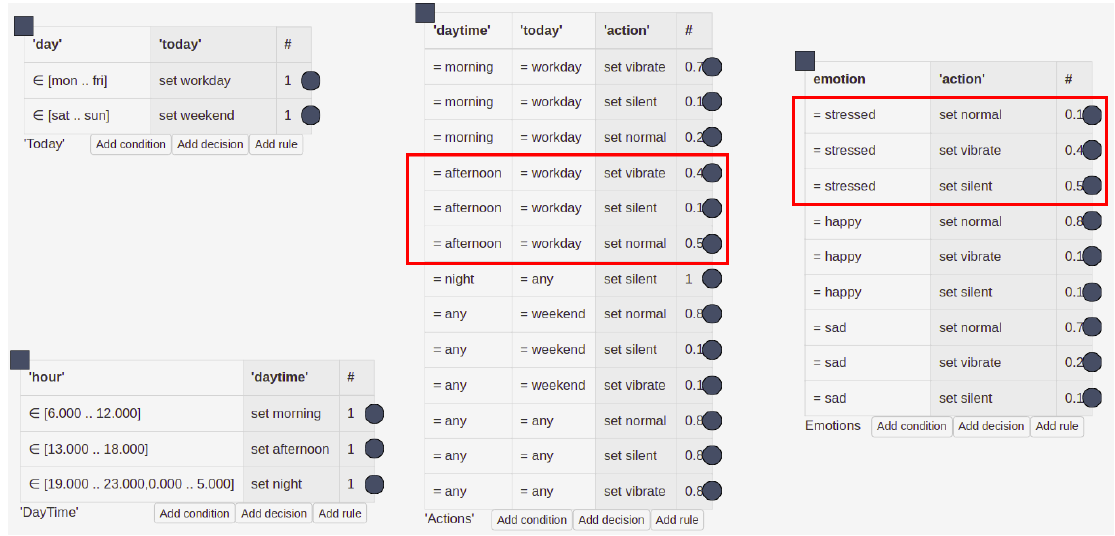
Figure 12. Simple context-aware model encoded in the HMR+ language. The column denoted with # contains the certainty factors of rules. The two red boxes represent rules that form a conflict